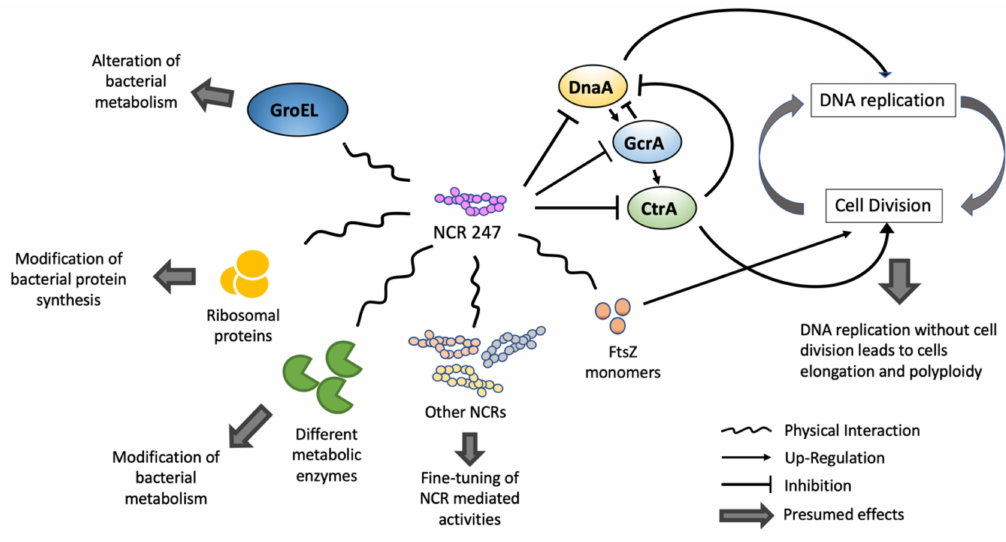
Figure 3. NCR247 modulates rhizobial activity via regulation of bacterial DNA replication, protein synthesis and metabolism. NCR247 appears to modulate a wide range of microbial pathways via directly repressing or binding to a range of bacterial proteins as well as other plant NCRs. It is possible that other yet to be characterized NCRs play similarly wide-ranging roles, supporting the diverse and important regulatory functions of NCRs during rhizobial